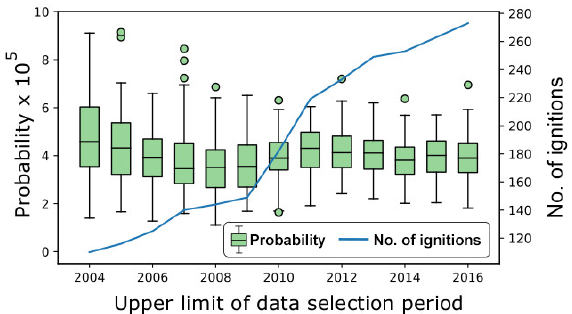
Figure 8. An illustration of the dependency on the number of data points of the robustness of the ignition probability map. The box- plots show the robustness of the ignition probability map as a func- tion of the data period that was used for construction, from 1994 to the upper limit. The line shows the actual number of data points used for model training.